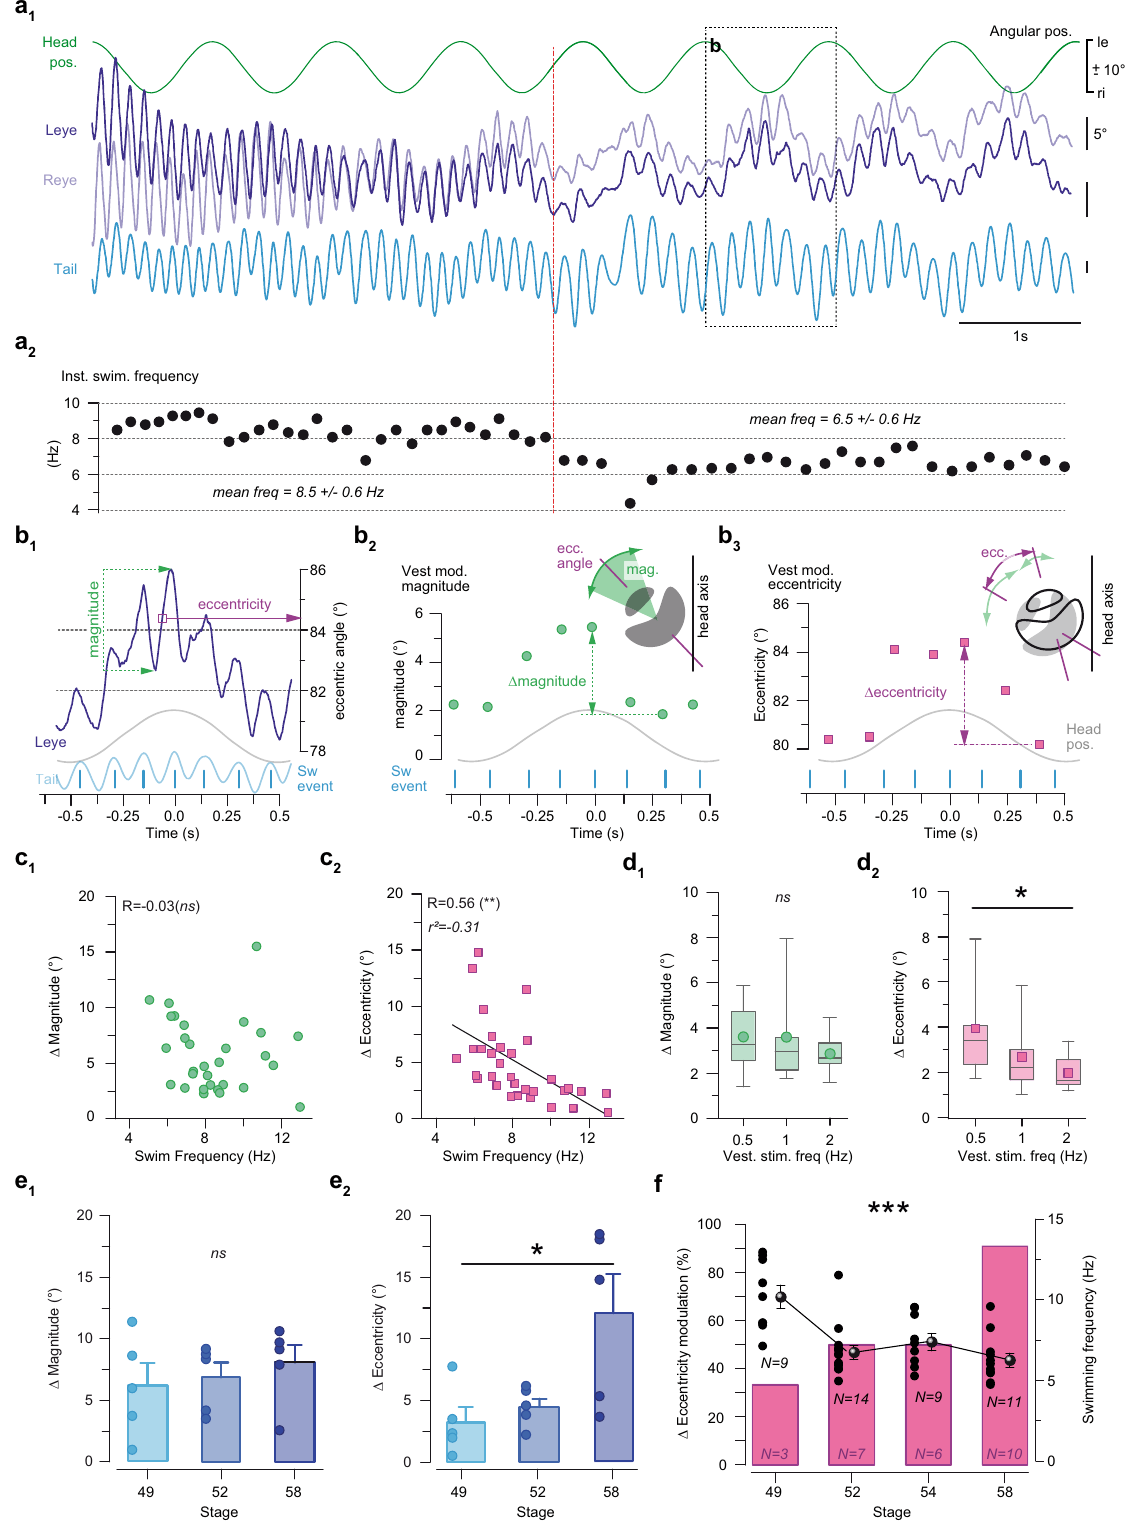
eccentricity occurred predominantly at lower tail undulatory modulation of the ocular eccentricity during swimming (Fig. 5e 2 ), frequencies (~6 Hz, Fig. 5f). Such low tail undulation frequencies larval age might only be an indirect classi fi er. As demonstrated are characteristic for the swimming of older larvae (see Fig. 4d, f), earlier 9,27 , the frequency of swim-related tail oscillations while exclusive variations of the ocular motion magnitudes were decreases progressively during larval development (black dots found, whenever swimming occurred at higher frequencies, which and spheres in Fig. 5f). Thus, when swim frequency is used as are more typical for stage 49 larvae (~10 Hz; Fig. 5f). parameter, vestibular-induced modulation of the ocular NATURE COMMUNICATIONS| (2022) 13:2957